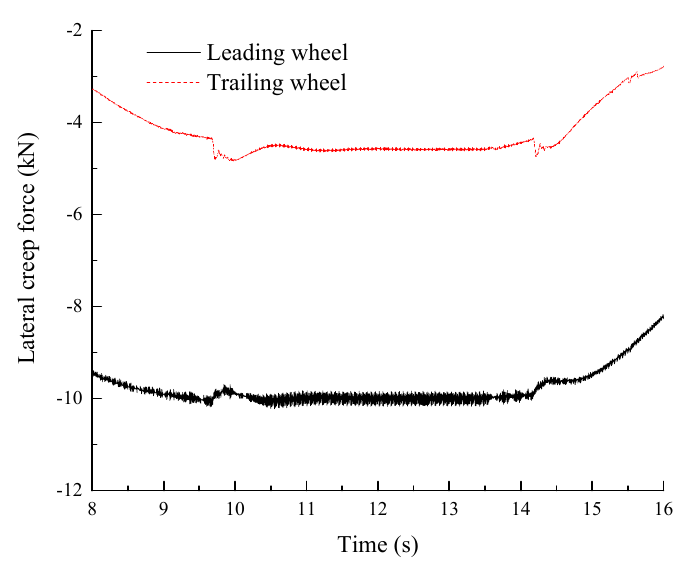
Figure 8. Lateral creep force of leading wheel and trailing wheel (simulation results).